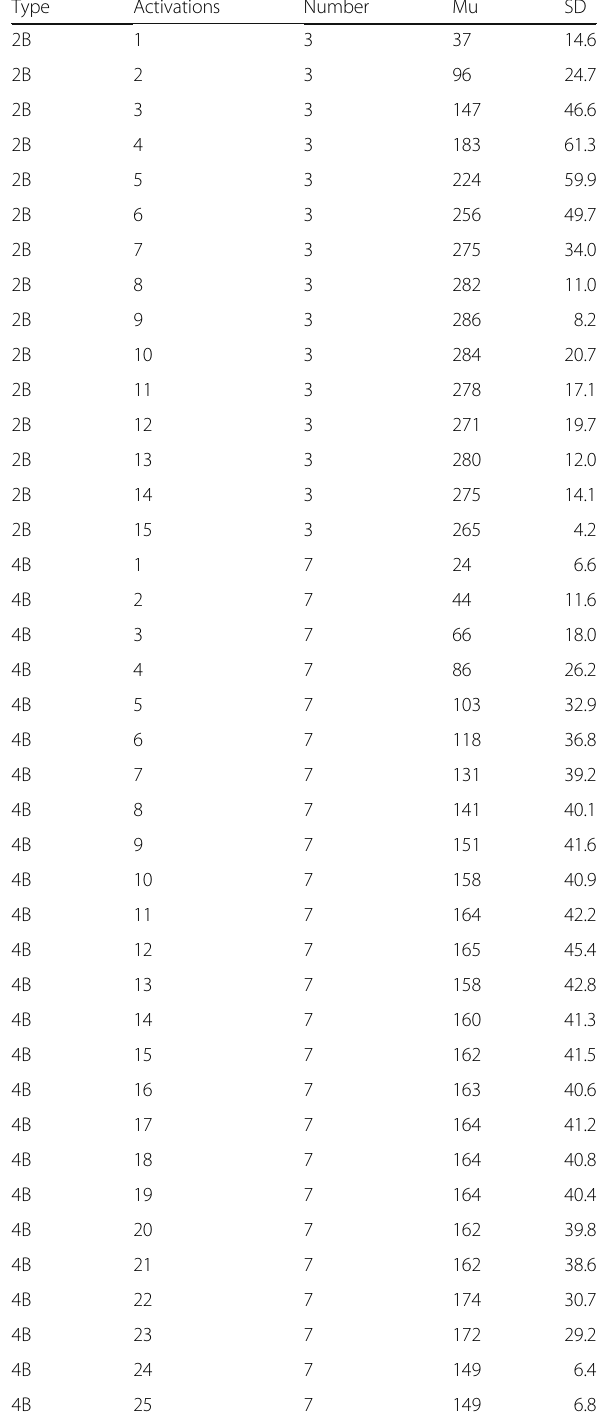
Table 3 Results of stiffness tests